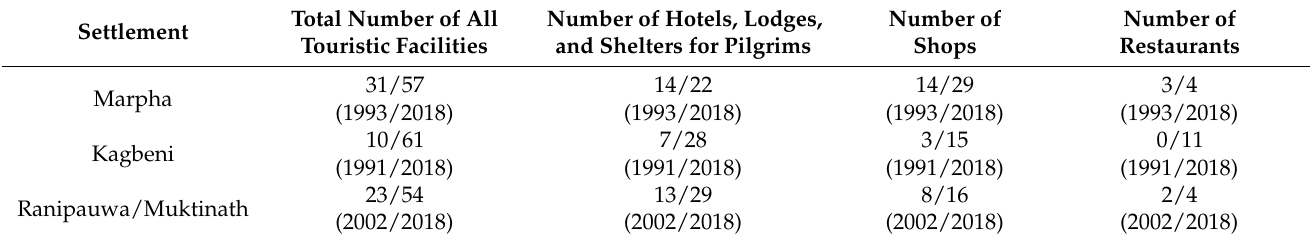
Table 2. Development of touristic facilities in Marpha and Kagbeni derived from historical map- ping [64,66] and recent remapping. For the Ranipauwa/Muktinath settlement, the functionality of the buildings is only assured in 2018. For 2002, only the presence or absence of the buildings is certain